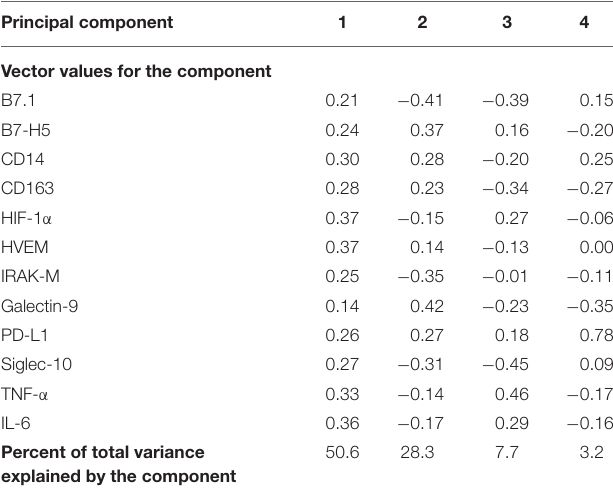
TABLE 2 | Principal component analysis of 10 immune markers from 30 pediatric samples from the study pediatric cohort. Principal